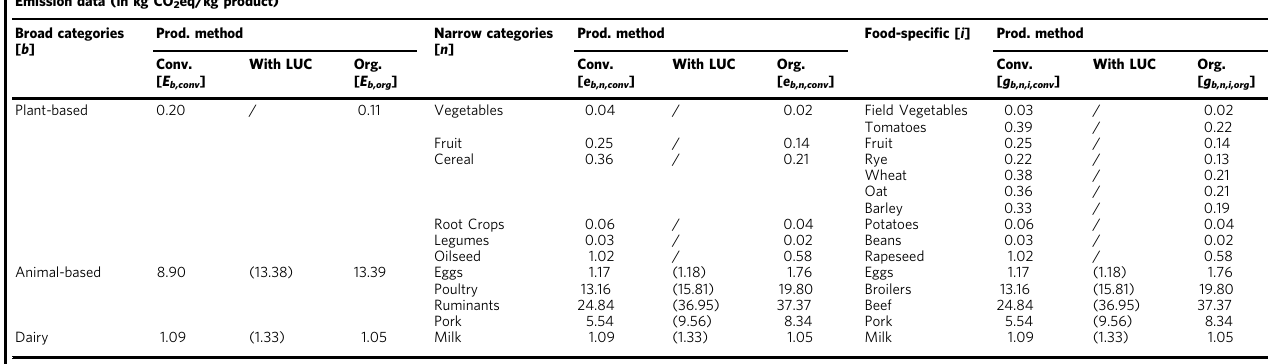
and Table 1); land-use change (LUC) data are approximated to be the LUC emissions of soymeal fodder, emissions of it are calculated with the method of Ponsioen and Blonk 45 . Emission data including LUC emissions are shown in brackets. Source data are provided as a source data fi